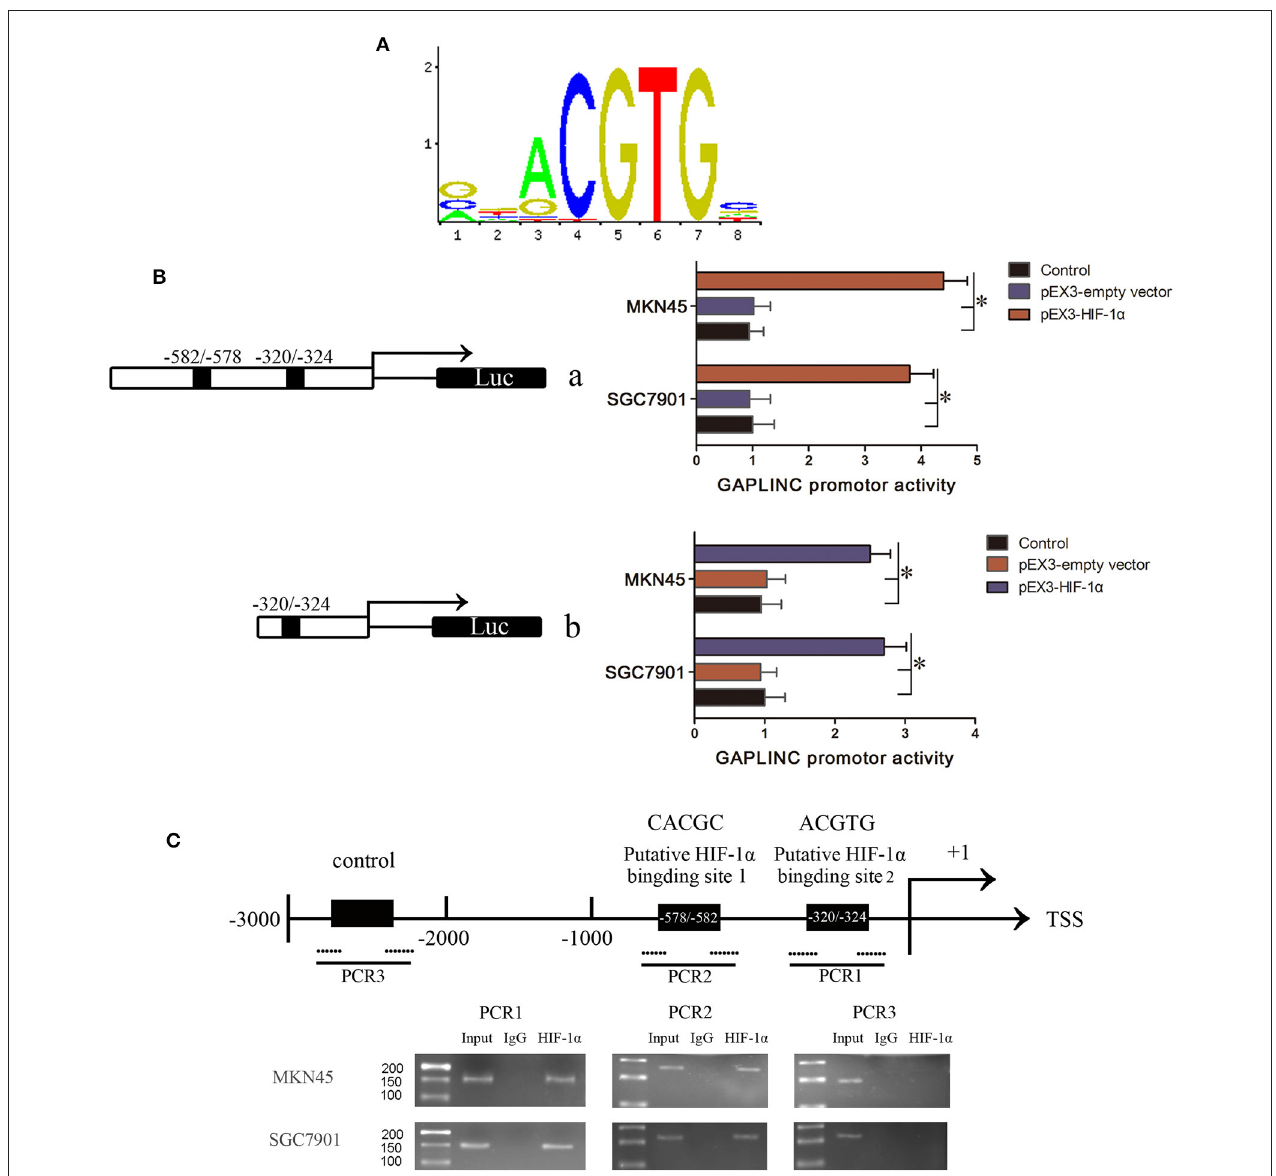
FIGURE 6 | HIF-1 α bound to the HRE of GAPLINC and triggered transcriptional activation. (A) The binding motif of HIF-1 α transcription pathway. (B) Effect of HIF-1 α on the promoter activities of GAPLINC in MKN45 and SGC7901 cells. Schematic depiction of the different reporter constructs (a and b) used and the luciferase activity. Plasmid activity after normalization with the co-transfected reference vector pRL-TK is shown in the X-axis. Background luminescence from cells transfected with empty pGL3-basic vector was substracted from the sample readings. (C) The ChIP assay indicated that HIF-1 α binds to the GAPLINC promoter in MKN45 and SGC7901 cells. Transcription start site (TSS) and putative HIF-1 α binding sites are indicated. Immunoprecipitated DNA was amplified by PCR. Normal rabbit IgG was used as a negative control. Visualized bands were considered as positive results and indicated endogenous binding of HIF-1 α to DNA fragments (* P <